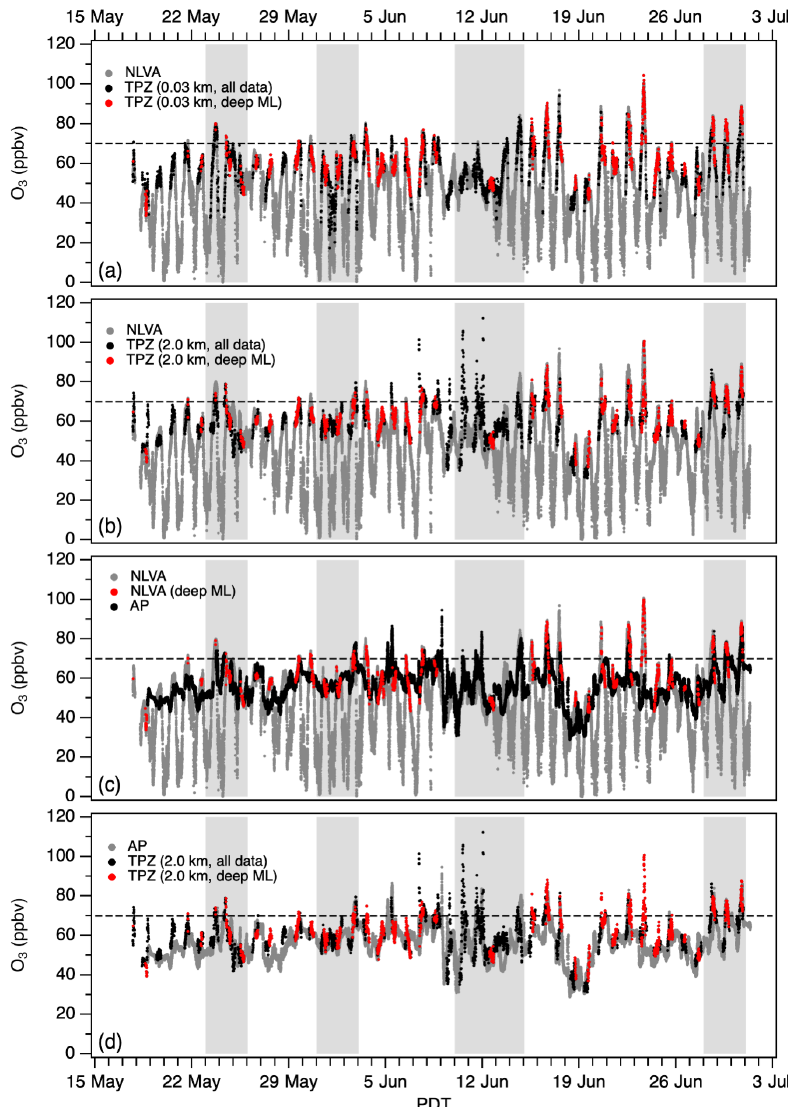
Figure 7. Time series comparing the TOPAZ O 3 mixing ratios with the NLVA and AP in situ measurements. (a) TPZ (0.03km) and NLVA surface monitor in the TOPAZ truck, (b) TPZ 2.0kma.g.l. and NLVA surface monitor, (c) NLVA and AP surface monitors, and (d) TPZ 2.0kma.g.l. and AP surface monitor. The gray bands show the four IOPs. The dashed horizontal lines show the 2015 NAAQS of 70ppbv. The red points highlight measurements made when the mixed layer was more than 2500m deep.